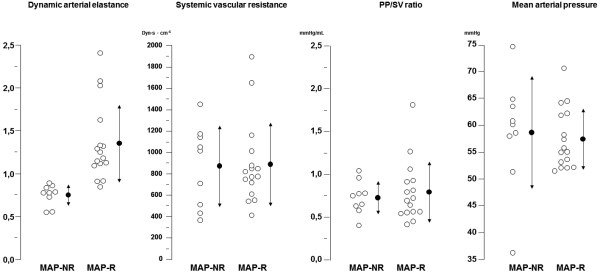
Distribution of individual arterial tone parameters at baseline. Individual values (open circles) and mean ± SD (closed circles) of arterial tone parameters before fluid administration in MAP responders (MAP-R) and MAP nonresponders (MAP-NR) with regard to dynamic arterial elastance (Eadyn), systemic vascular resistance (SVR), pulse pressure to stroke volume ratio (PP/SV ratio) and baseline MAP.